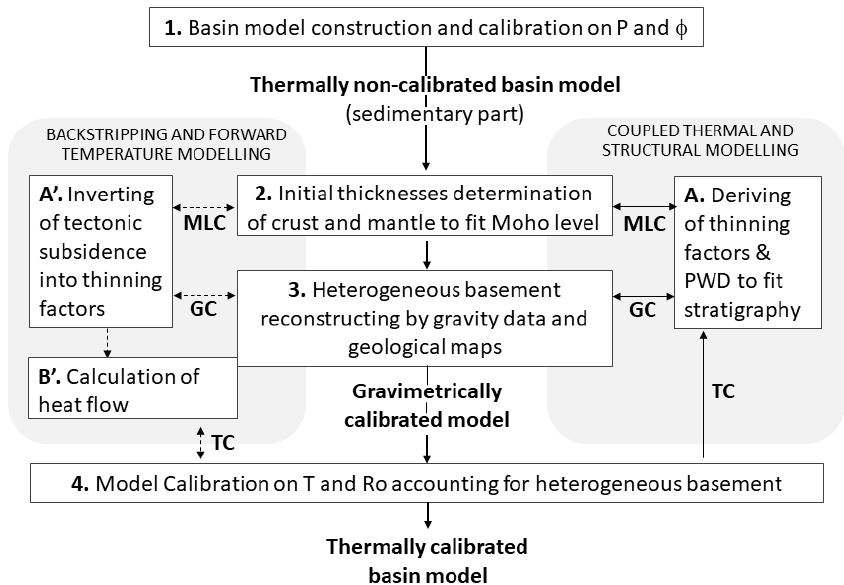
erogeneous basement, where φ is porosity, P is pressure, T is temperature, Ro is vitrinite reflectance, PWD stands for paleo-water depth, MLC stands for Moho-level calibration, GC stands for gravity calibration and TC stands for thermal calibration. The solid arrows show the path for the coupled solution used in the case study, the dashed arrows show the path for a backstripping-based solution, and the bidirectional arrows indicate additional simulations during model calibration.